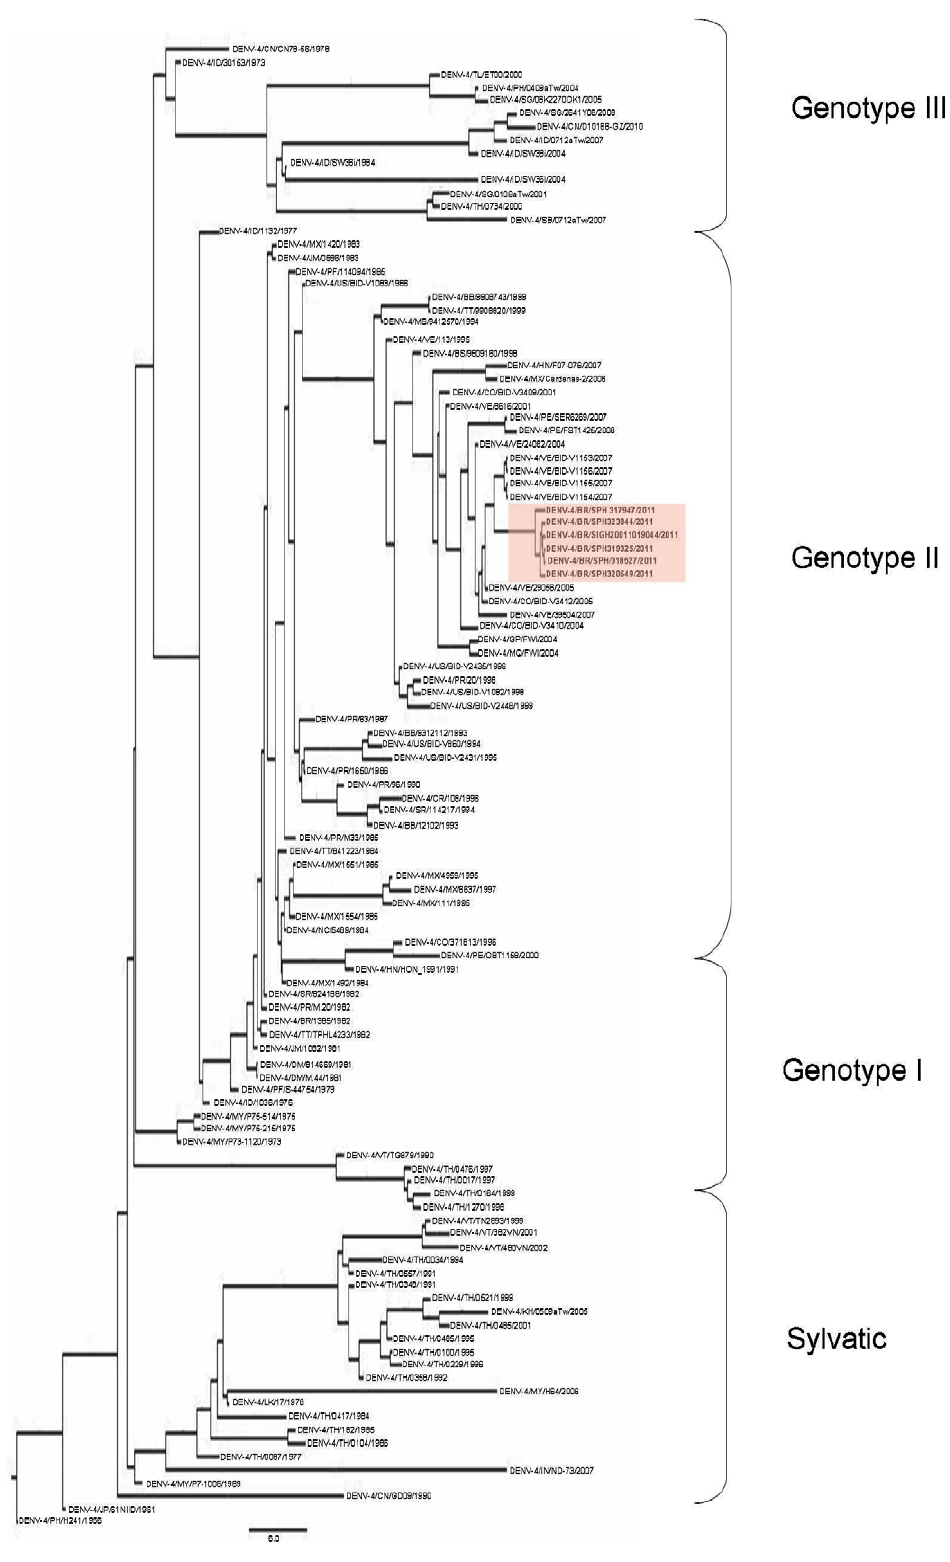
Figure 1. Envelope gene MCMC tree. The internal nodes were inferred using a Markov Chain Monte Carlo (MCMC) Bayesian approach under a GTR model with Gamma-distributed rate variation ( c ) and a proportion of invariable sites (I), using a relaxed (uncorrelated lognormal) molecular clock. Four independent MCMC runs of four chains each were run for 10 millions generations. The highlighted sector indicates the position of the studied strains.